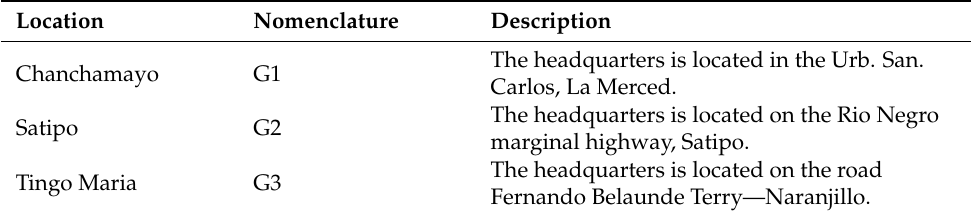
Table 1. Groups in the case study.